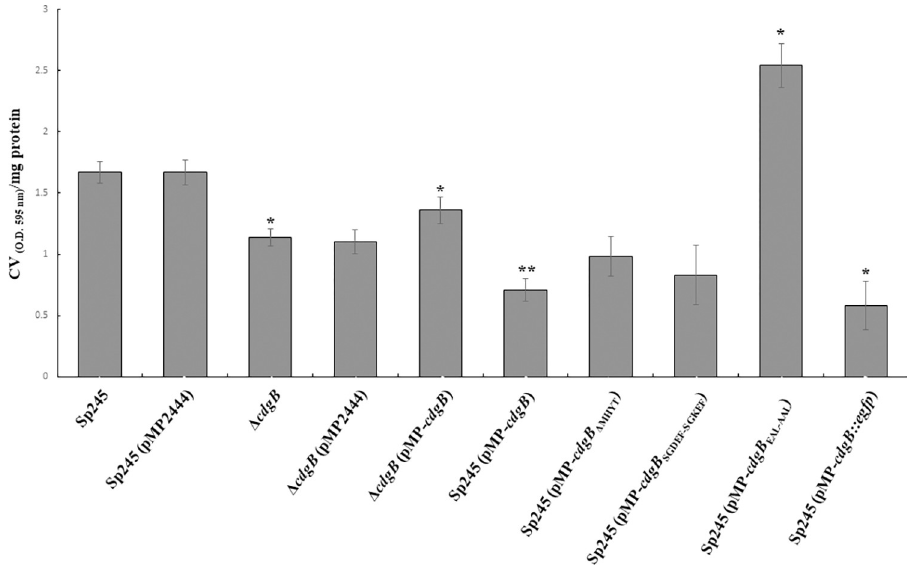
Fig 4. CdgB alters biofilm formation in A. baldaniorum Sp245. Graph representing the mean and standard deviation of biofilm quantification from 5 days of growth in statical conditions at 30˚C. Data represent results of three independent experiments with three biological replicates. Significant differences relative to WT (P < 0.05) are indicated by “ � ”and to + cdgB (P < 0.005) by “ �� ” according to Student´s t-test.